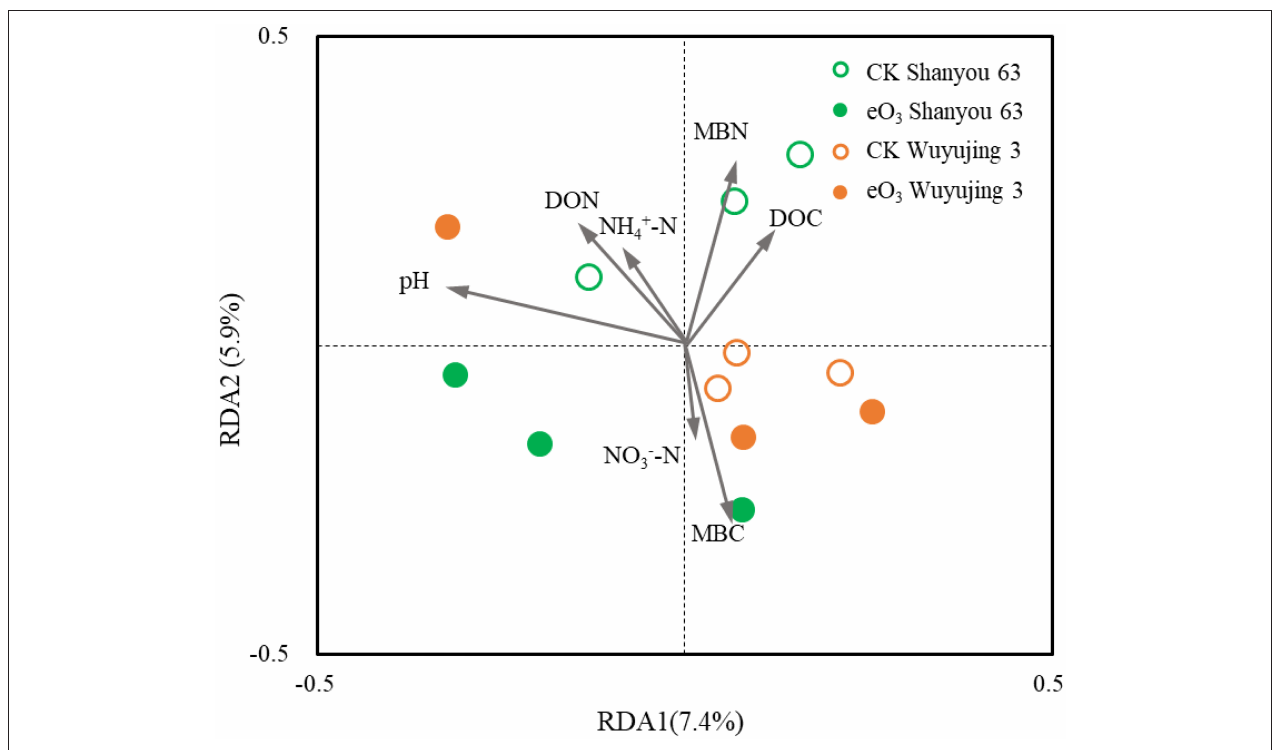
FIGURE 3 | Redundancy analysis (RDA) of the relationships between soil properties and soil nematode community under elevated